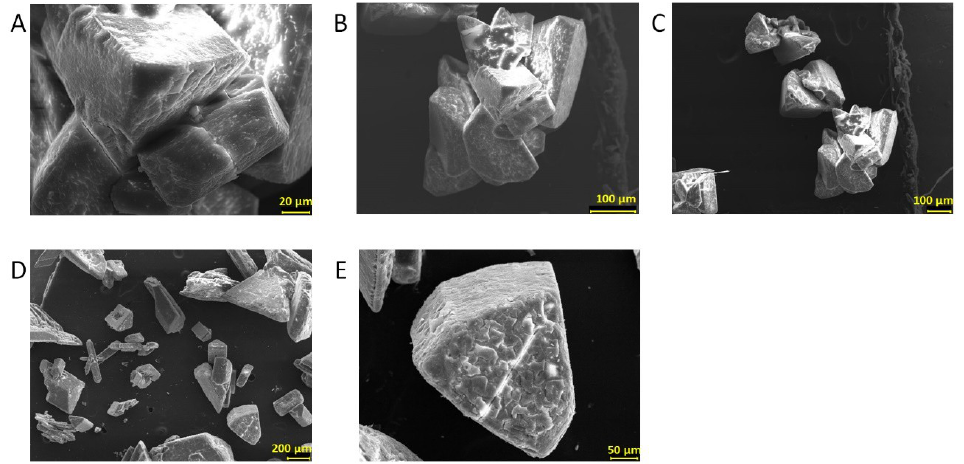
Figure 6. Scanning electron microscopy images of biominerals precipitated in the ME medium under constant ( A – C ) and variable ( D , E ) salinity conditions.